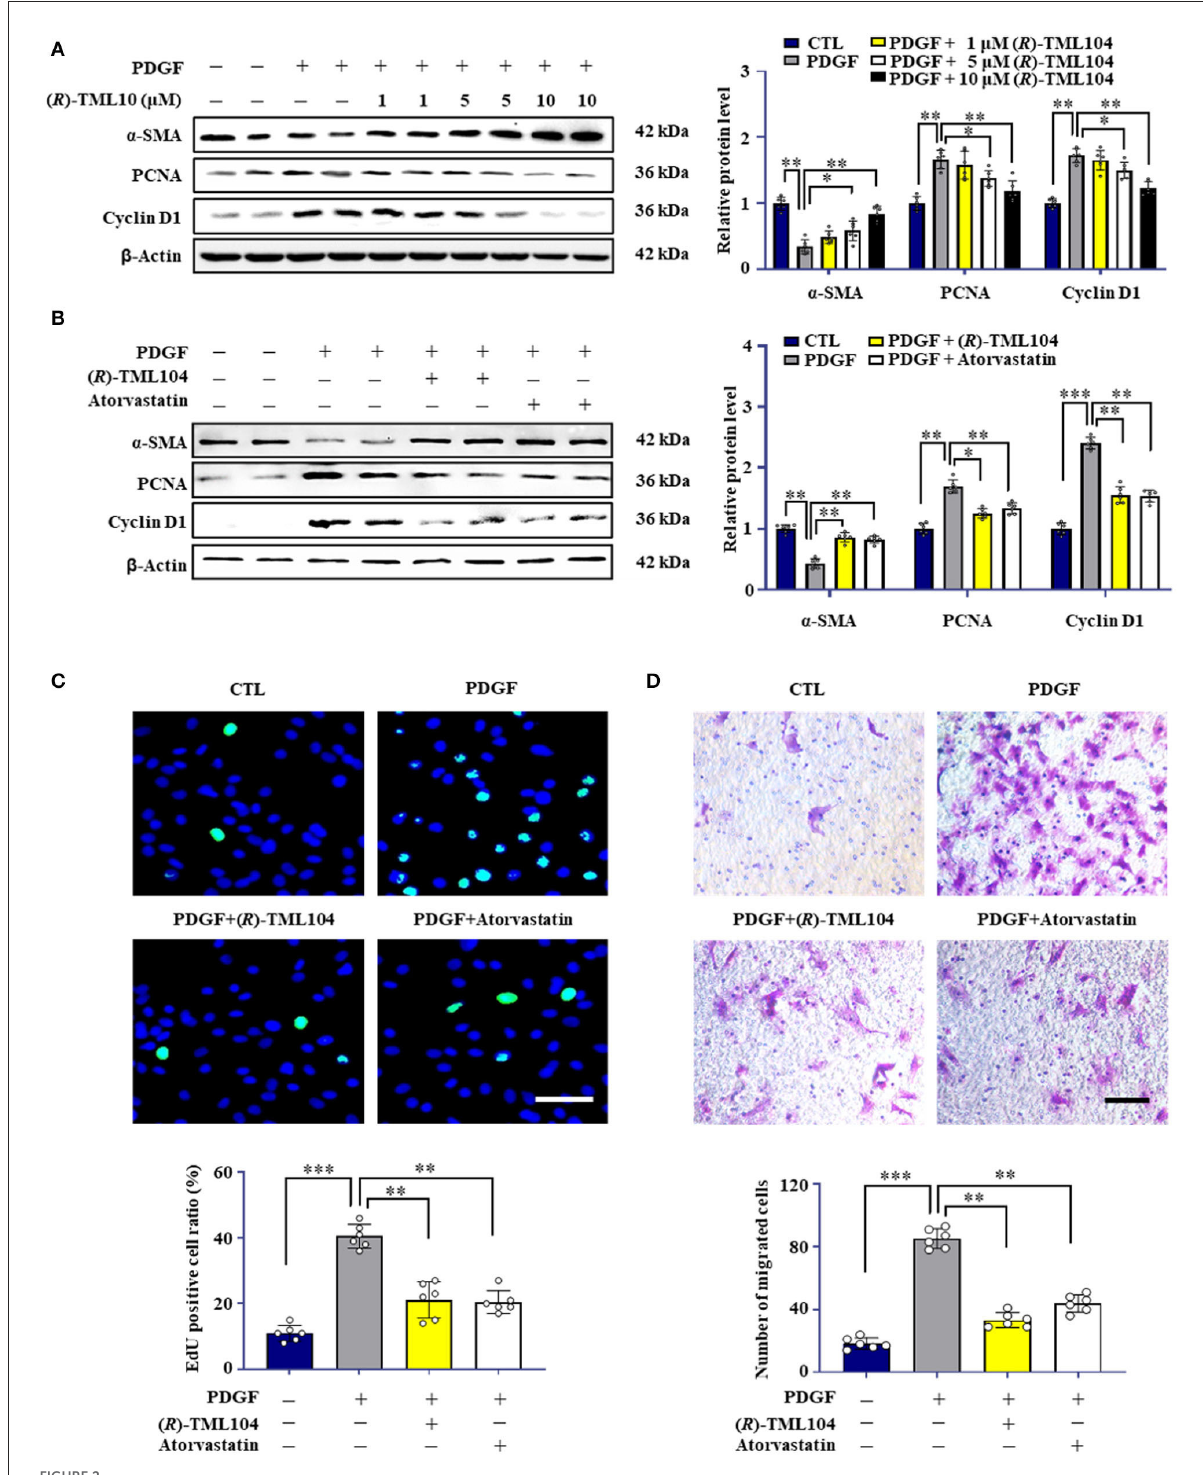
FIGURE2 ( R )-TML104 inhibits PDGF-BB-induced VSMC phenotypic transformation in vitro . (A) VSMC were pretreated with ( R )-TML104 for 4h and then stimulated with PDGF-BB (20ng/mL) for 24h. The protein levels of α -SMA, PCNA, and cyclin D1 were determined by western blotting. (B) The protein levels of α -SMA, PCNA, and cyclin D1 were determined by western blotting. (C) DNA synthesis in VSMC was determined with an EdU incorporation assay. Blue fluorescence (Hoechst 33342) showed cell nuclei and green fluorescence (EdU) stands for cells with DNA synthesis. (D) Transwell assay was performed to determine the migration of VSMC. Scale bar: 50 µ m, Data shown are means ± S.D ( n = 6). * p < 0.05, ** p < 0.01, *** p <